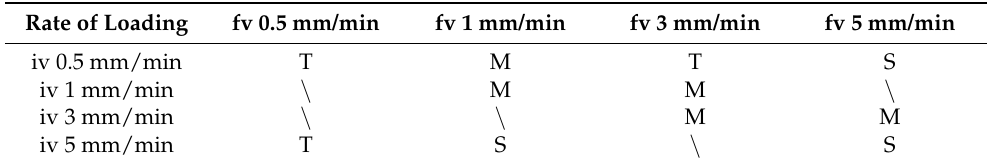
Table 4. Statistical table of 30–60 failure modes of specimens.